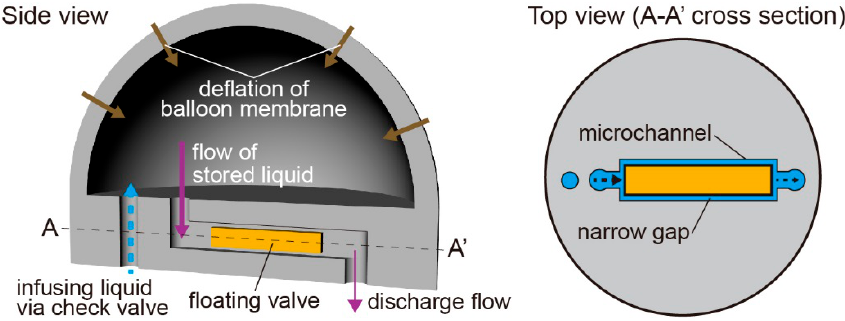
Figure 1. Conceptual illustration of a balloon pump with a floating valve.